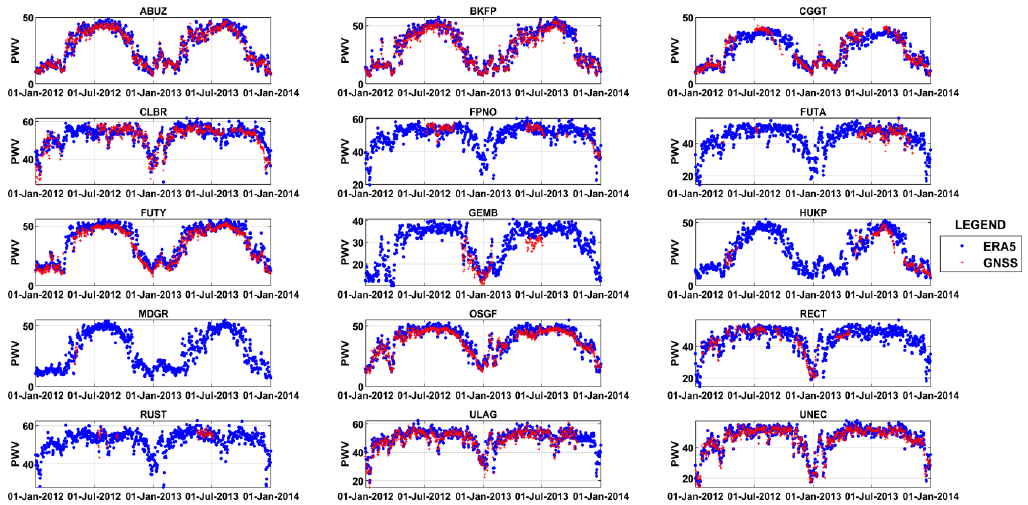
Figure 7. Diurnal variation of PWV derived from GNSS and ERA5 during the period 2012–2013. Units are in mm or kg/m 2